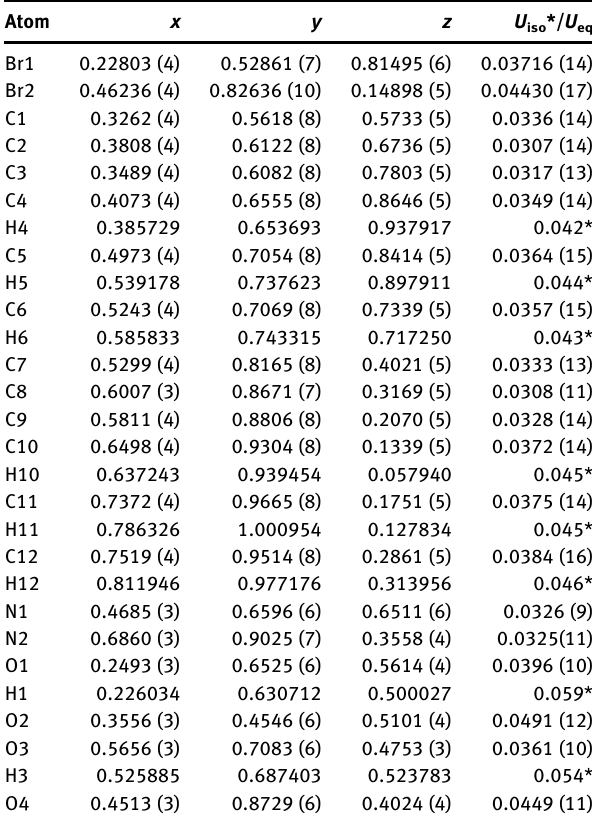
Table  : Fractional atomic coordinates and isotropic or equivalent isotropic displacement parameters (Å 